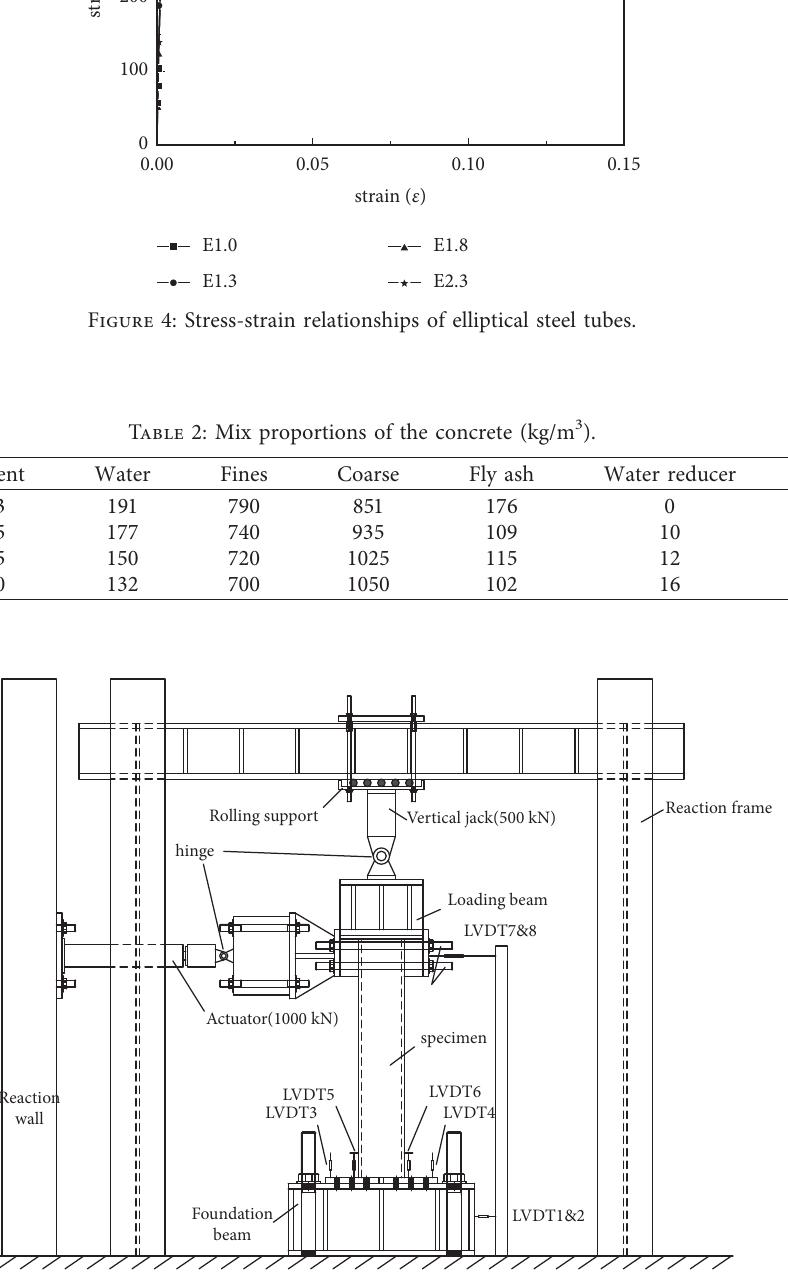
Figure 5: Test setup and instrumentation.